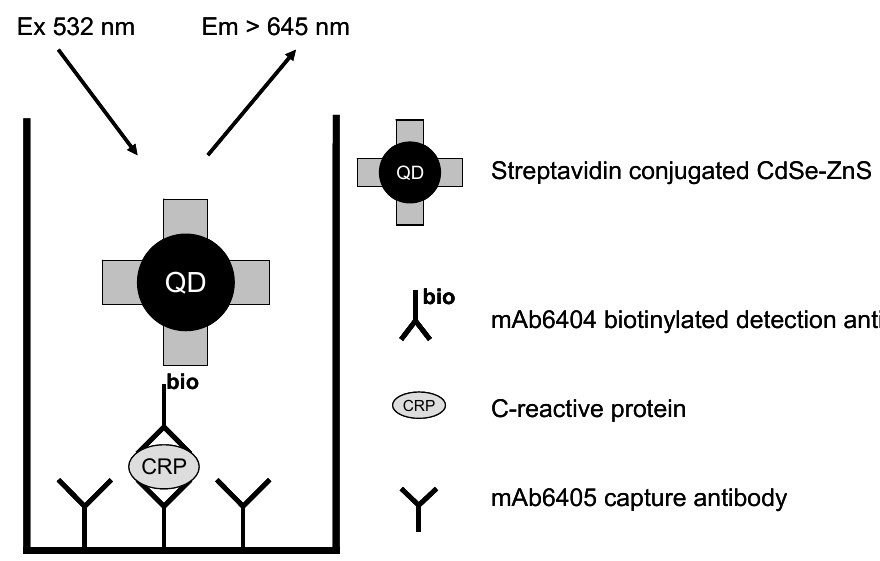
Figure 4. Principle of the C-reactive protein immunoassay. Antibody captures C-reactive protein to the microtiter well surface. After washing biotinylated detection antibody reacts with the surface-formed complex. Excess of detection antibody was removed and streptavidin-conjugated CdSe-ZnS particles detect the bound biotin correlating with the C- reactive protein concentration.